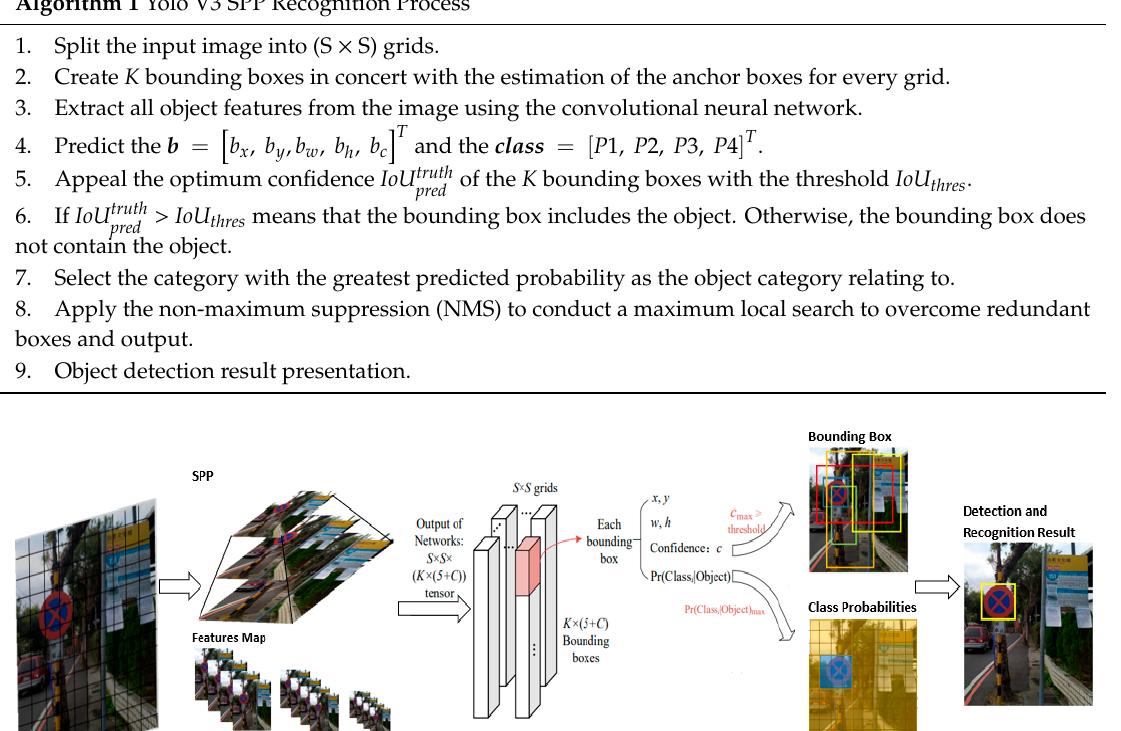
Algorithm 1 Yolo V3 SPP Recognition Process